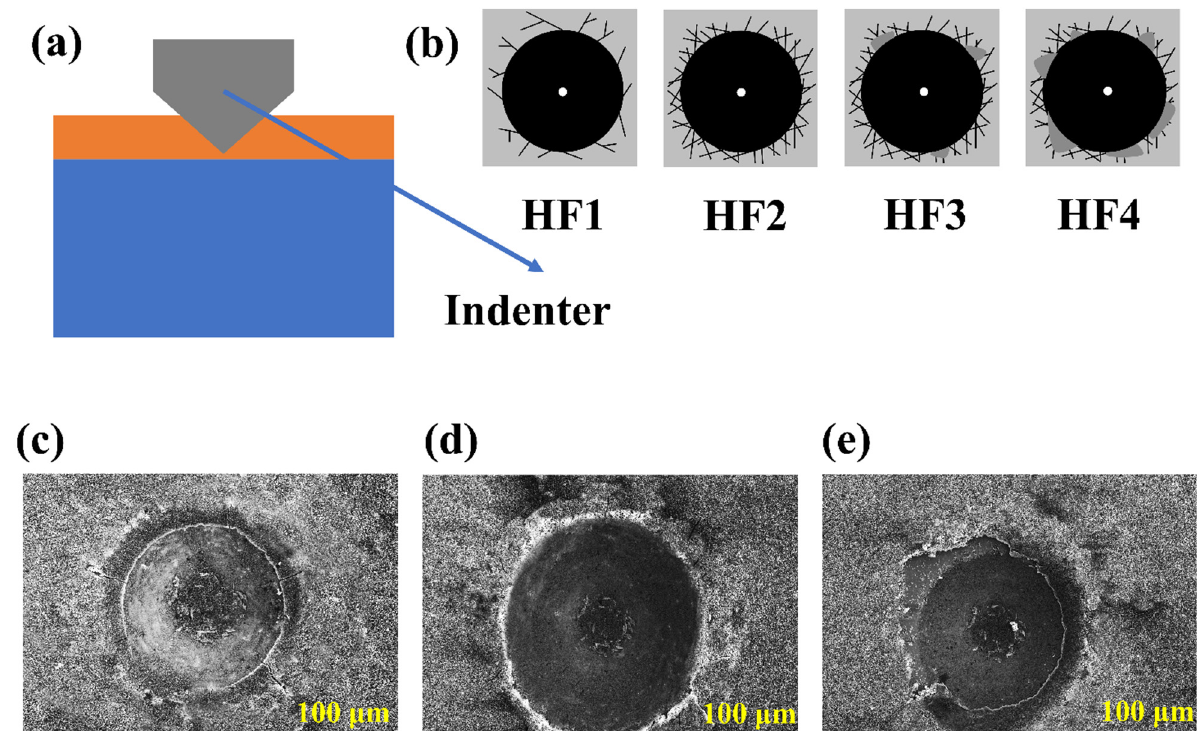
Figure 5. ( a ) Schematic diagram of the indentation test, ( b ) Indentation image for acceptable adhesion strength. The indentation pattern of ( c ) sample with 40 V 30 s ( d ) sample with 40 V 60 s, and ( e ) sample with 40 V 120 s.